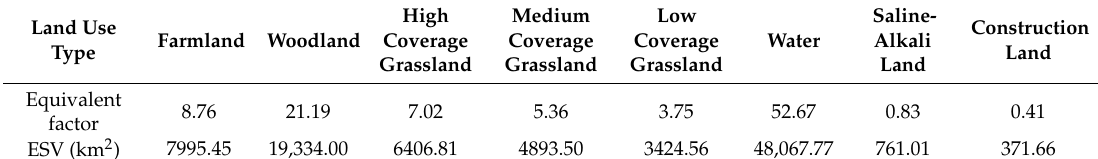
Table A4. Value of ecosystem services of di ff erent land use types.